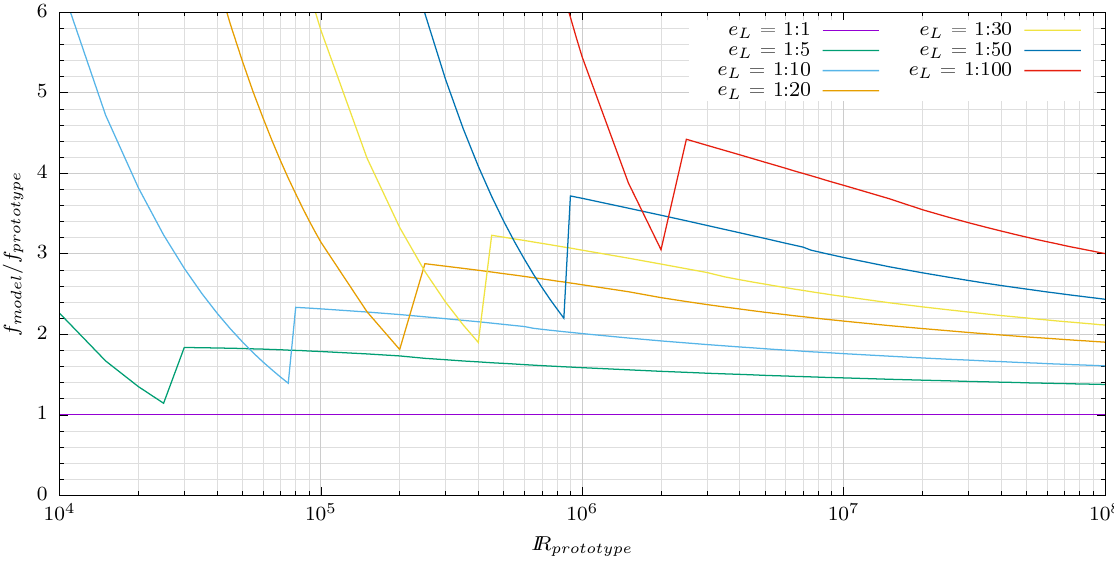
Figure 2: Relation between physical model and prototype friction factors for hydraulically smooth circular